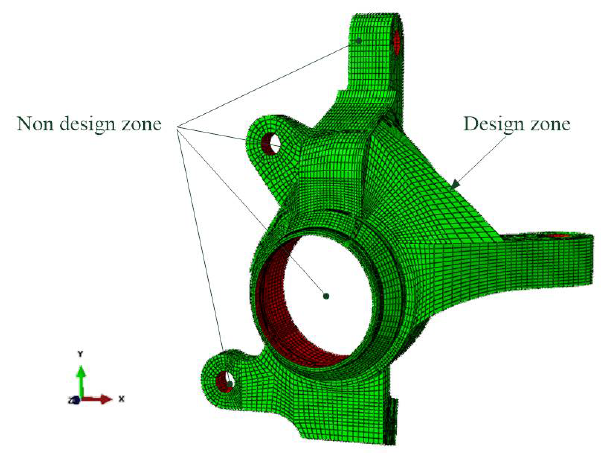
Figure 3. Dimensional constraints for optimized knuckle compo- nent.